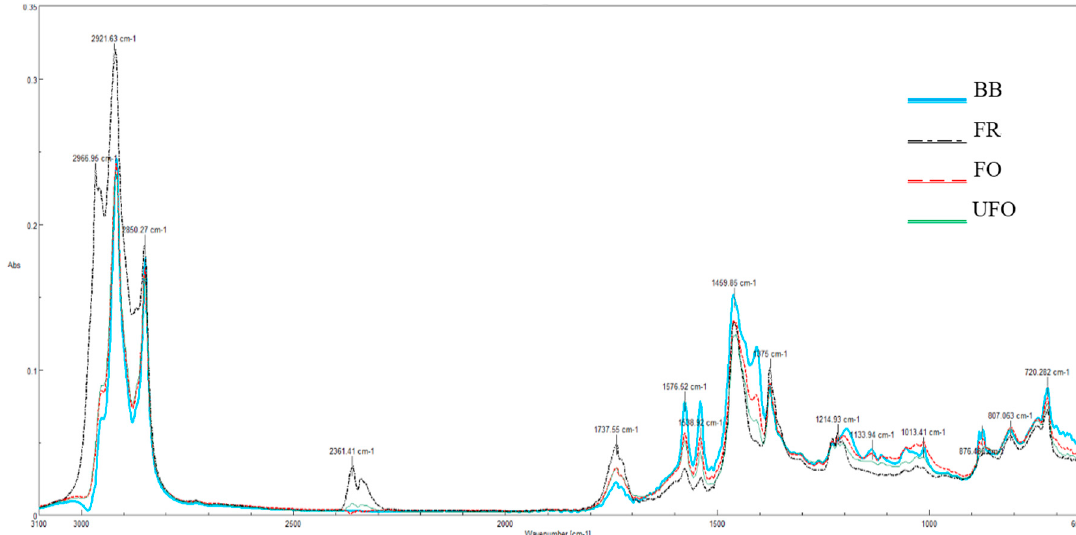
Figure 5. FTIR spectra comparison of unaged asphalt binders.